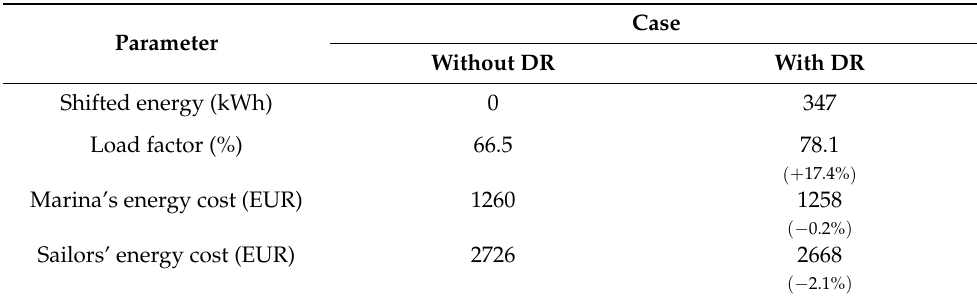
Table 2. Simulation results for all boats participating in DR programme for a week. Parameter